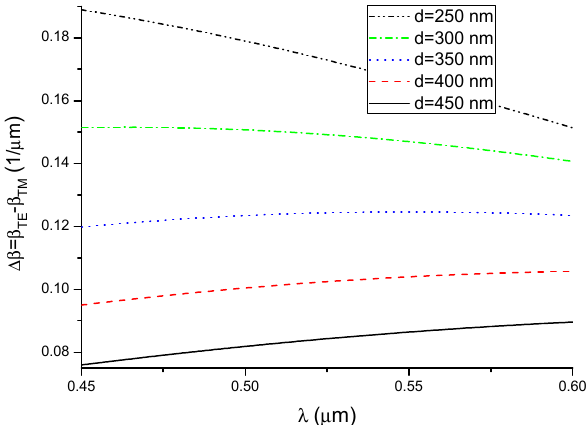
Figure 6. Di ff erence in propagation constants as a function of Figure 6. Difference in propagation constants as a function of wavelength.